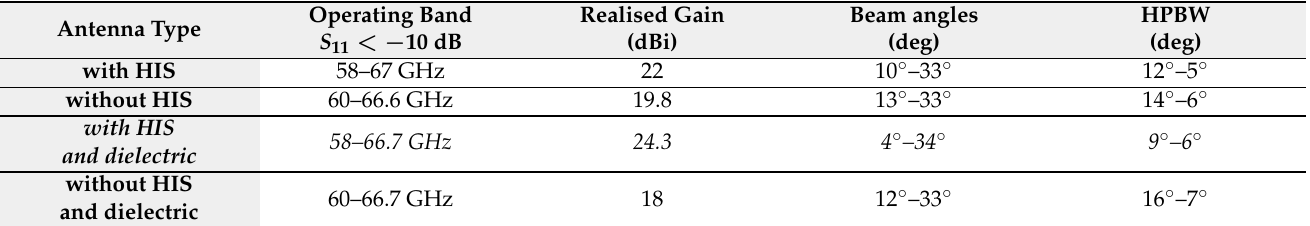
( a ) ( b ) Figure 8. Simulated LWA models ( a ) S 11 and ( b ) realised gain for four different LWA configurations. Table 1. Comparison of simulated LWA results at a resonant frequency of 62.5